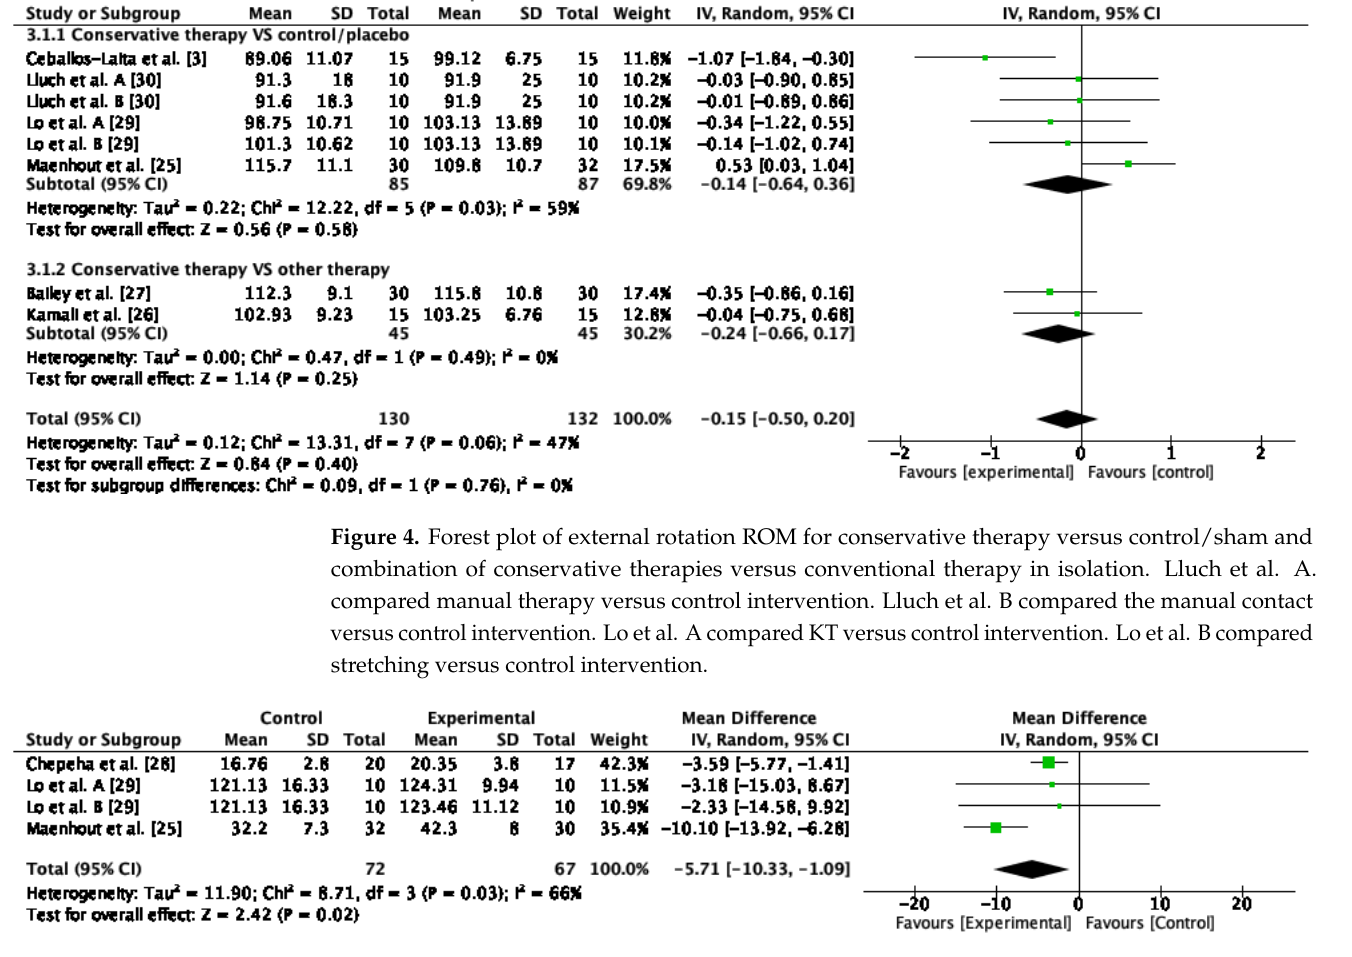
Figure 5. Forest plot of adduction ROM for conservative therapy versus control/sham and conserva- tive therapy versus other conservative therapy. Lo et al. A compared KT versus control intervention. Lo et al. B compared stretching versus control intervention.